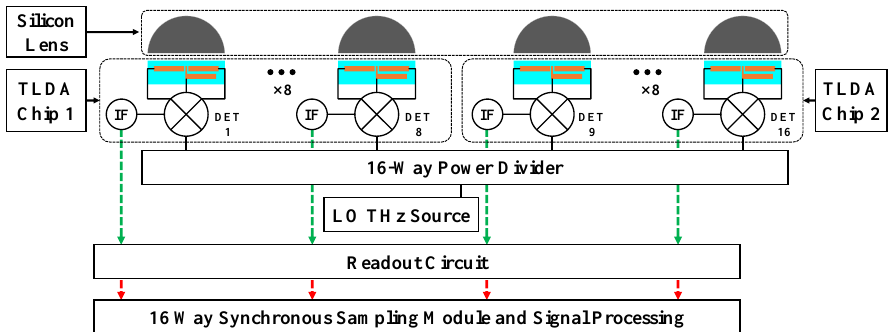
Figure 1. The architecture of the proposed terahertz heterodyne receiver front-end.